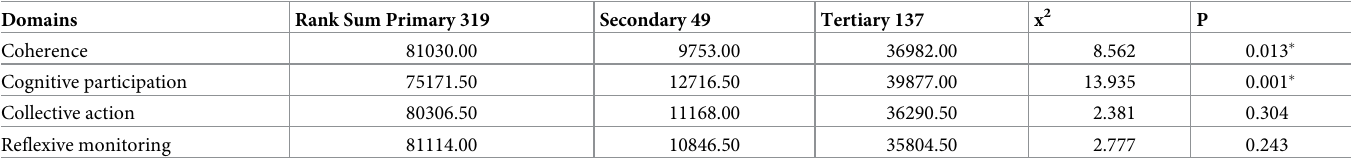
Table 5. Difference between levels of healthcare facilities by the mechanism of EmONC integration (n = 505).